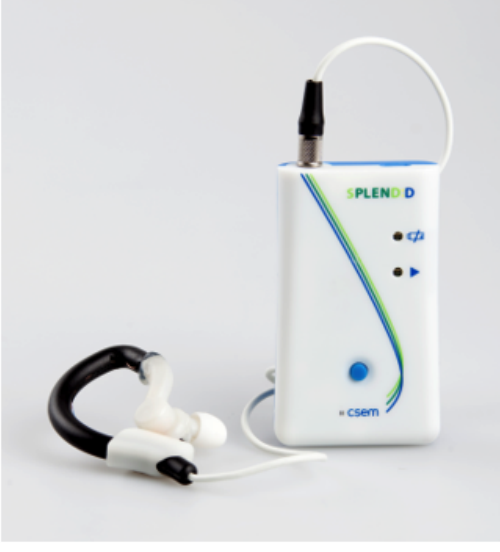
Figure 5. Integrated version of the SPLENDID eating detection sensor with its